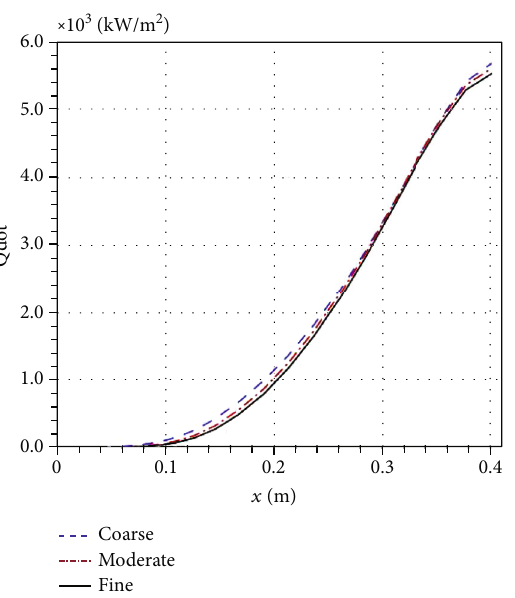
Figure 9: Results of _ Q distribution on the model windward surface center line from di ff erent